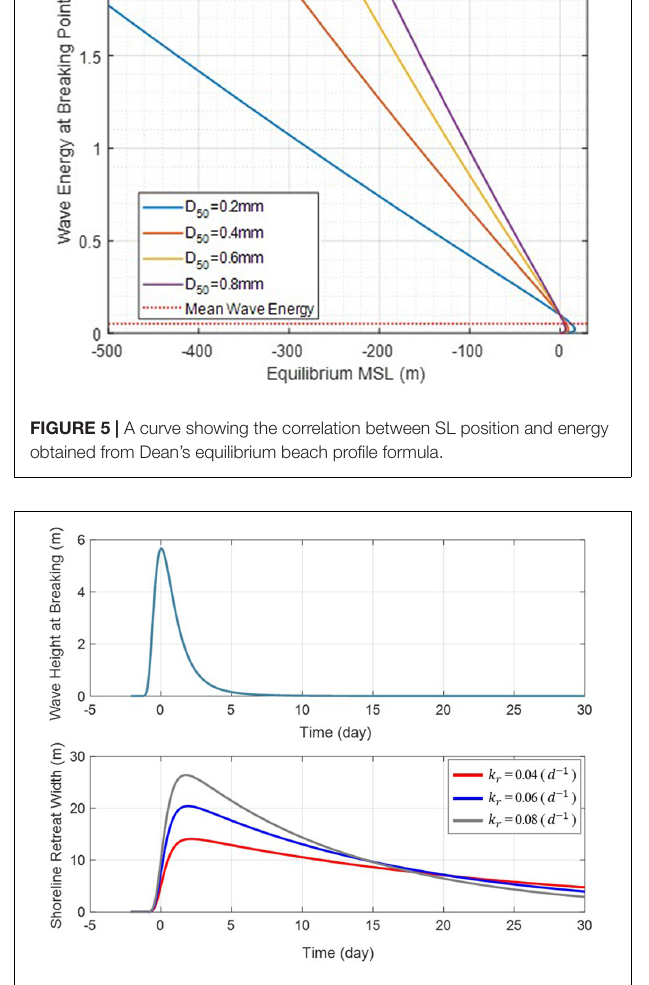
FIGURE 6 | Time evolution of wave scenario and shoreline retreat width for 3 different k r values.